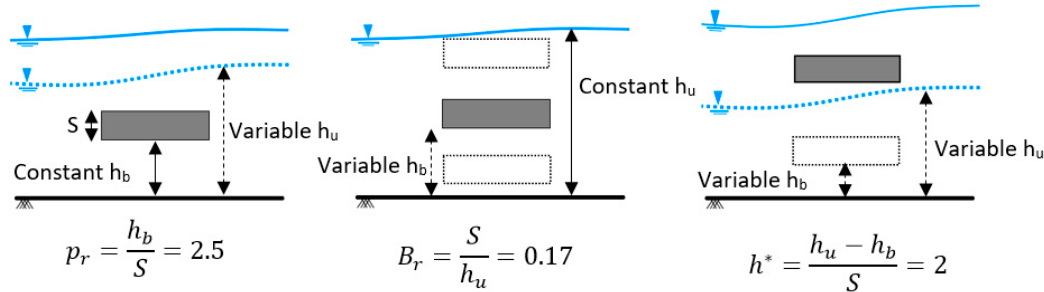
Figure 17. Bridge and water depth configurations. Scenario1 (left picture): Fixed proximity ratio, p r = 2.5. Scenario 2 (middle picture): Constant Blockage ratio, B r = 0.17. Scenario 3 (right picture): Constant inundation ratio, h* = 2.